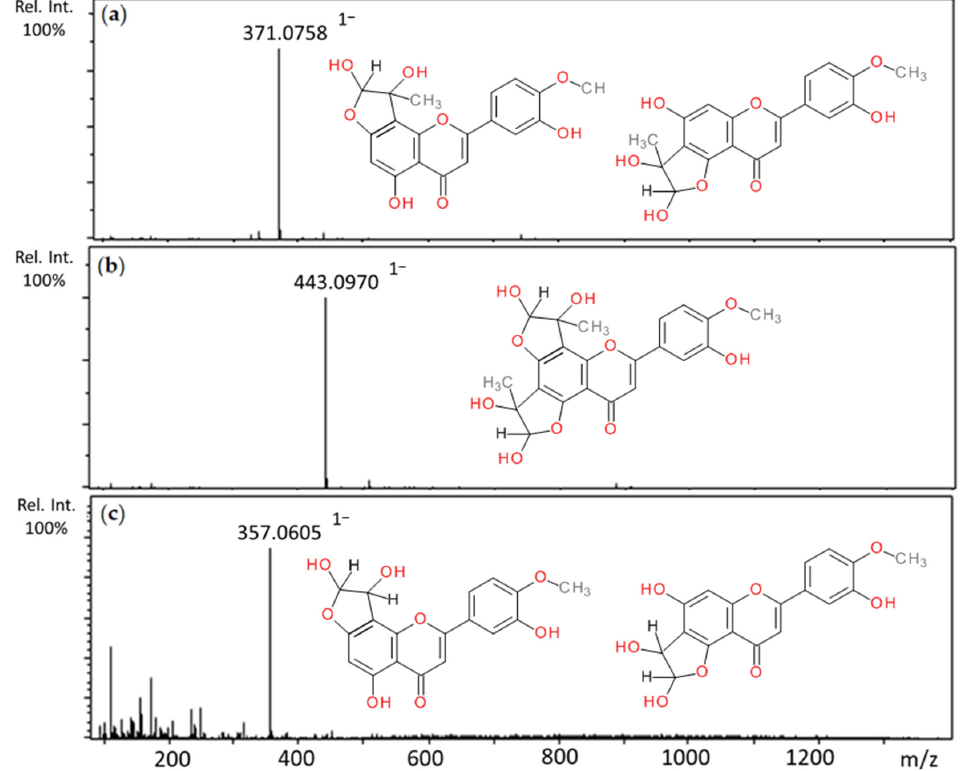
Figure 5. Mass spectra of methylglyoxal and glyoxal adducts with diosmetin after 1 h incubation in pH 7.4 phosphate buffer solution at 37 °C and their proposed chemical structure: ( a ) mono-MGO-diosmetin; ( b ) di-MGO-diosmetin; ( c ) mono-GO-diosmetin; other isomeric forms are also